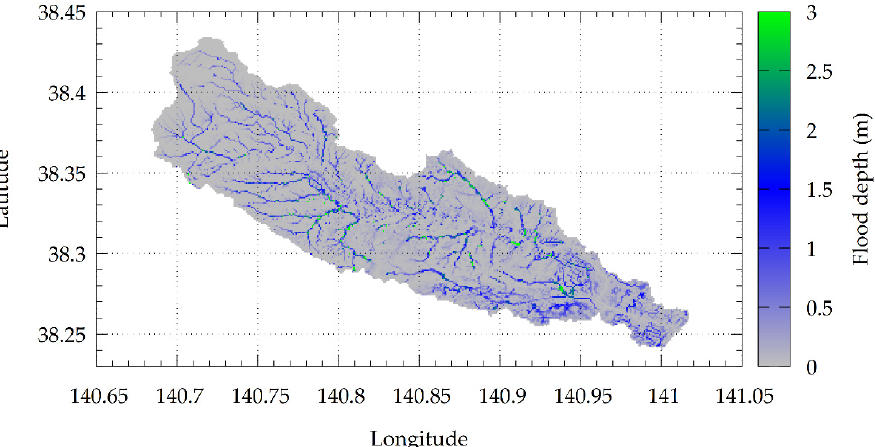
Figure 9. RRI-simulated peak inundation caused by the typhoon event in the river basin shown in Figure 1b.